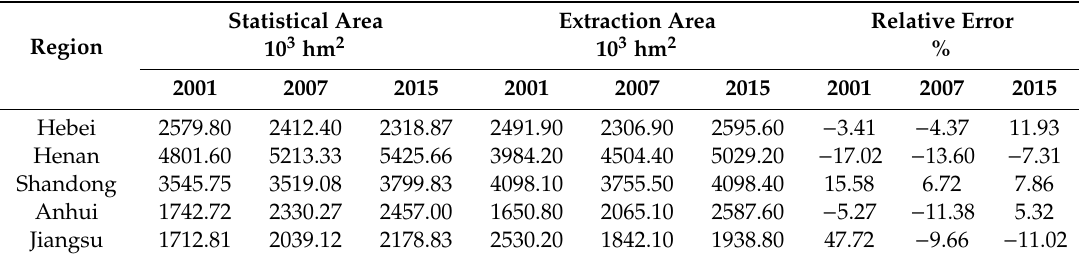
Table 1. Comparison between the winter wheat cultivating zones from EVI and that from statistics yearbook in major winter wheat